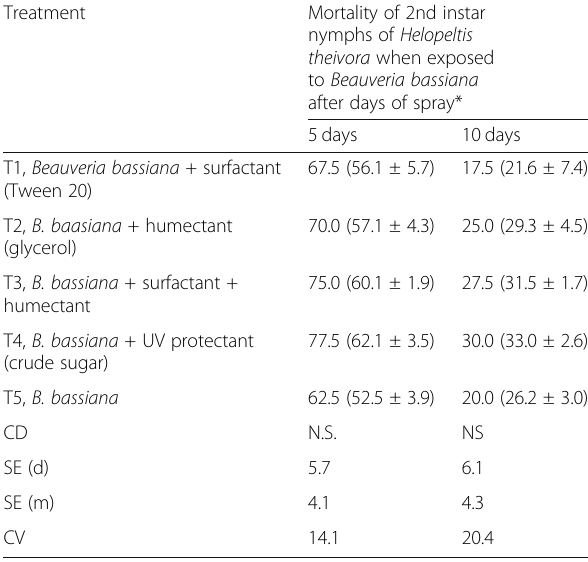
Table 3 In vitro bioefficacy of Beauveria bassiana against Helopeltis theivora in combination with different adjuvants Treatment Mortality of 2nd instar nymphs of Helopeltis theivora when exposed to Beauveria